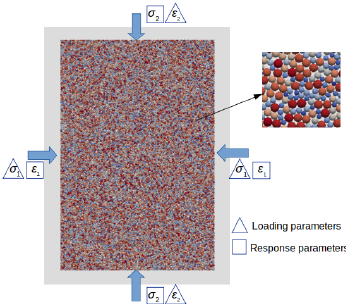
Figure 1. 2D DEM specimen for a biaxial test where loading parameters are ε 1 and σ 2